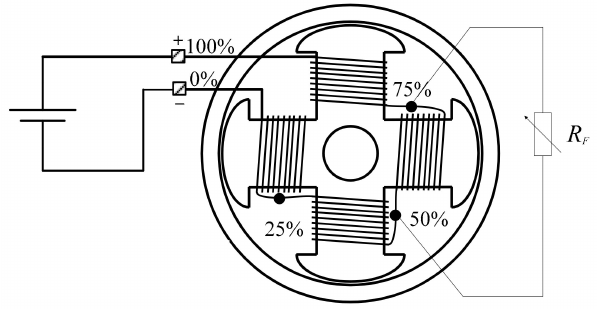
Figure 5. Synchronous machine rotor